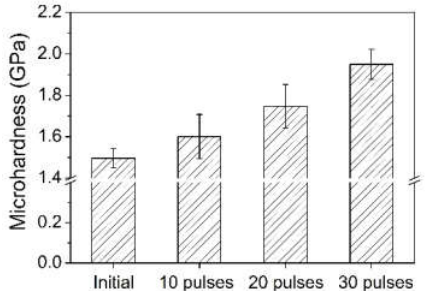
Figure 4. Microhardness measurements of pure nickel and Ni-Sn samples after HCPEB irradiation.